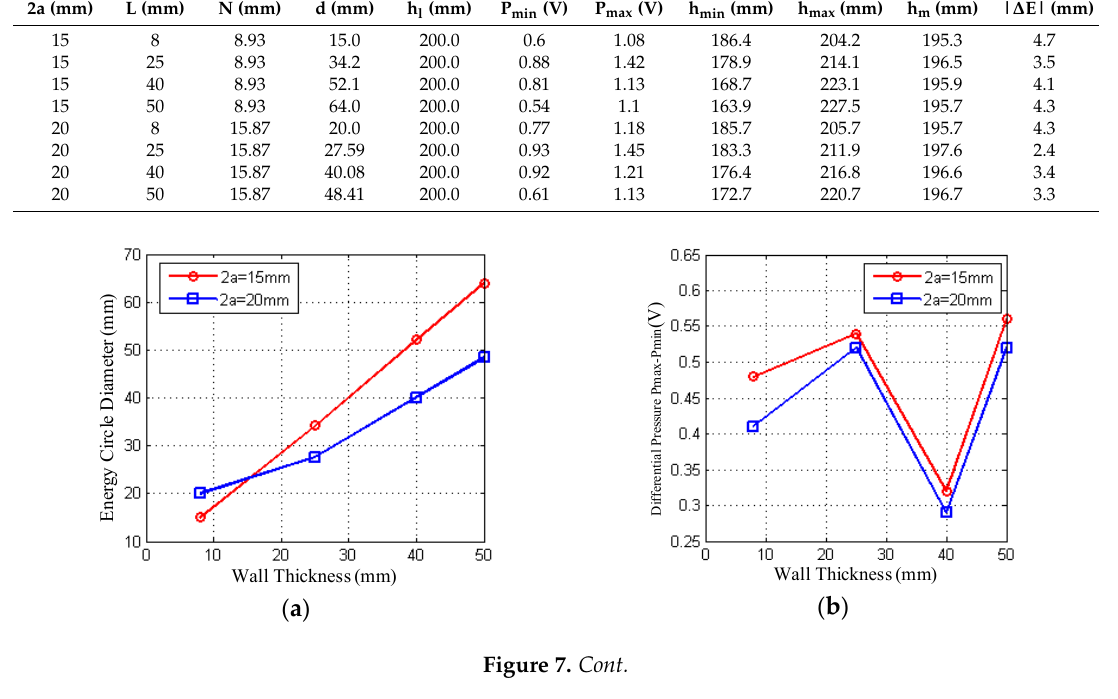
Table 3. Result of liquid level test.